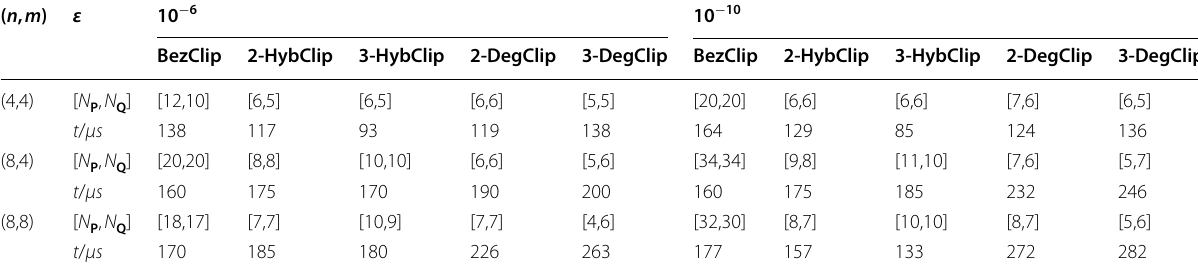
Table 2 Tangent intersections